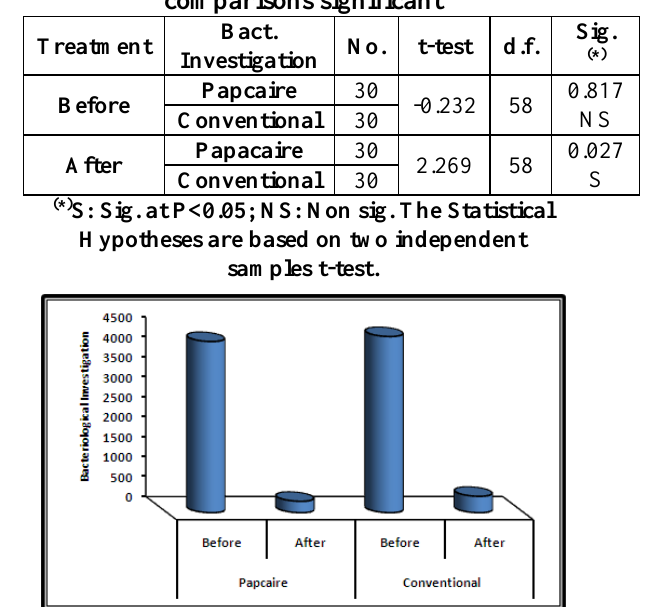
Figure 1: Bar Chart of